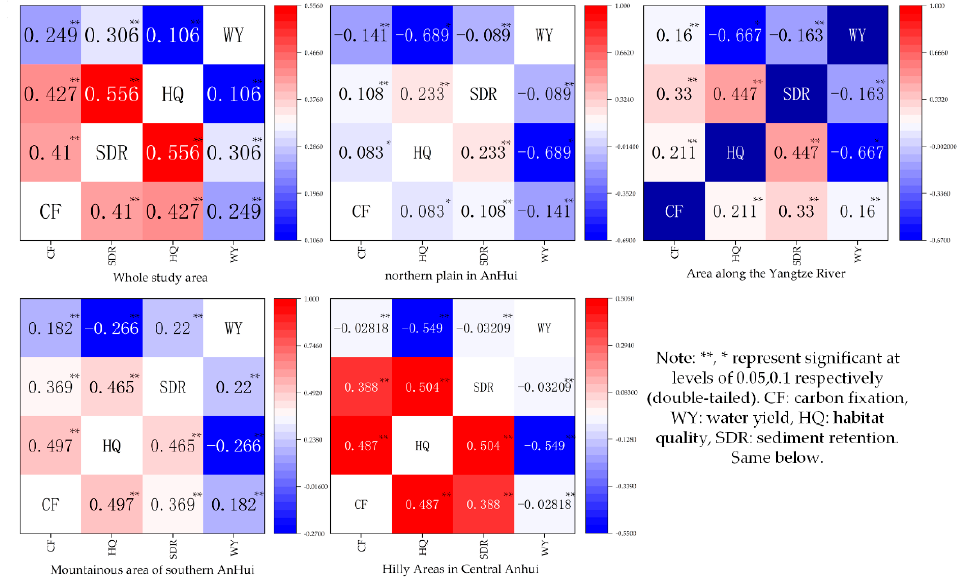
Figure 4. Ecosystem services correlations in Anhui Province.